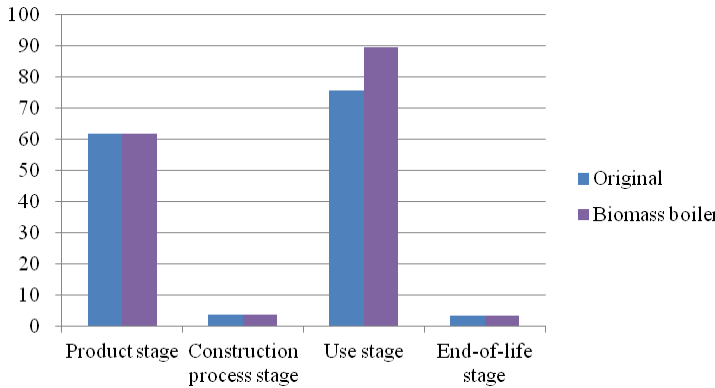
Figure 7. Comparison of the cumulative primary energy demand (in kWh-Eq/m 2 year *) in the building analyzed according to the biomass boilers